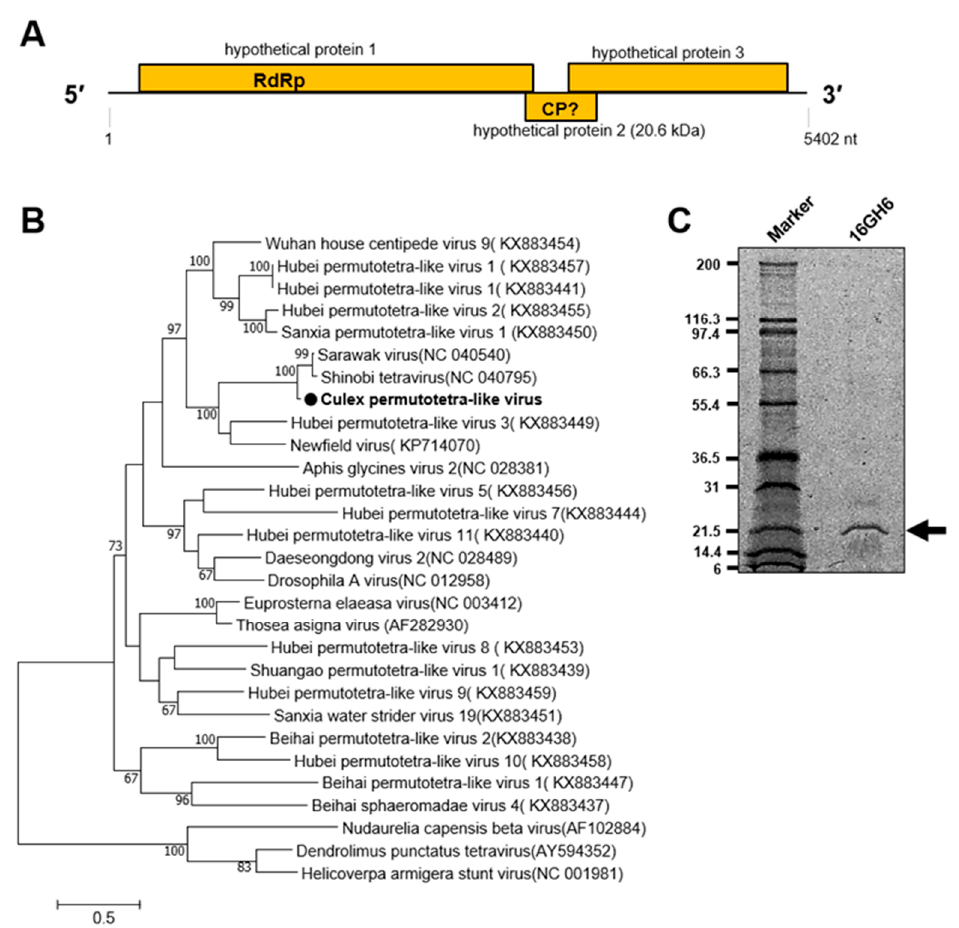
Figure 8. Genetic characterization of Culex permutotetra-like virus (CxPTV). ( A ) Genome structure showing hypothetical protein 2 as possibly coding for the capsid protein. ( B ) Evolutionary history of CxPTV. The maximum likelihood tree was constructed using the complete amino acid domain of the genome sequence with Genbank accession number LC505019. The amino acid domain was aligned using the MAFFT 7 online version [27]. Bootstrap support values from 1000 bootstrap replicates are indicated on the branches. ( C ) Gel representation of CxPTV protein.